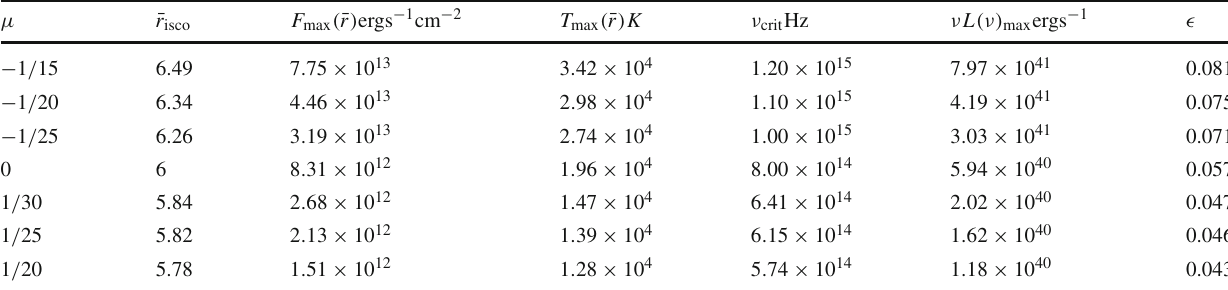
Table 1 The maximum values of the energy flux F max ( ¯ r ) , the disk temperature T max ( ¯ r ) , and ν L (ν) max of the accretion disk around a BH in EACT. The ISCO radius, the cut-off frequency ν crit , and the Novikov–Thorne efficiency (cid:17) are also shown in the